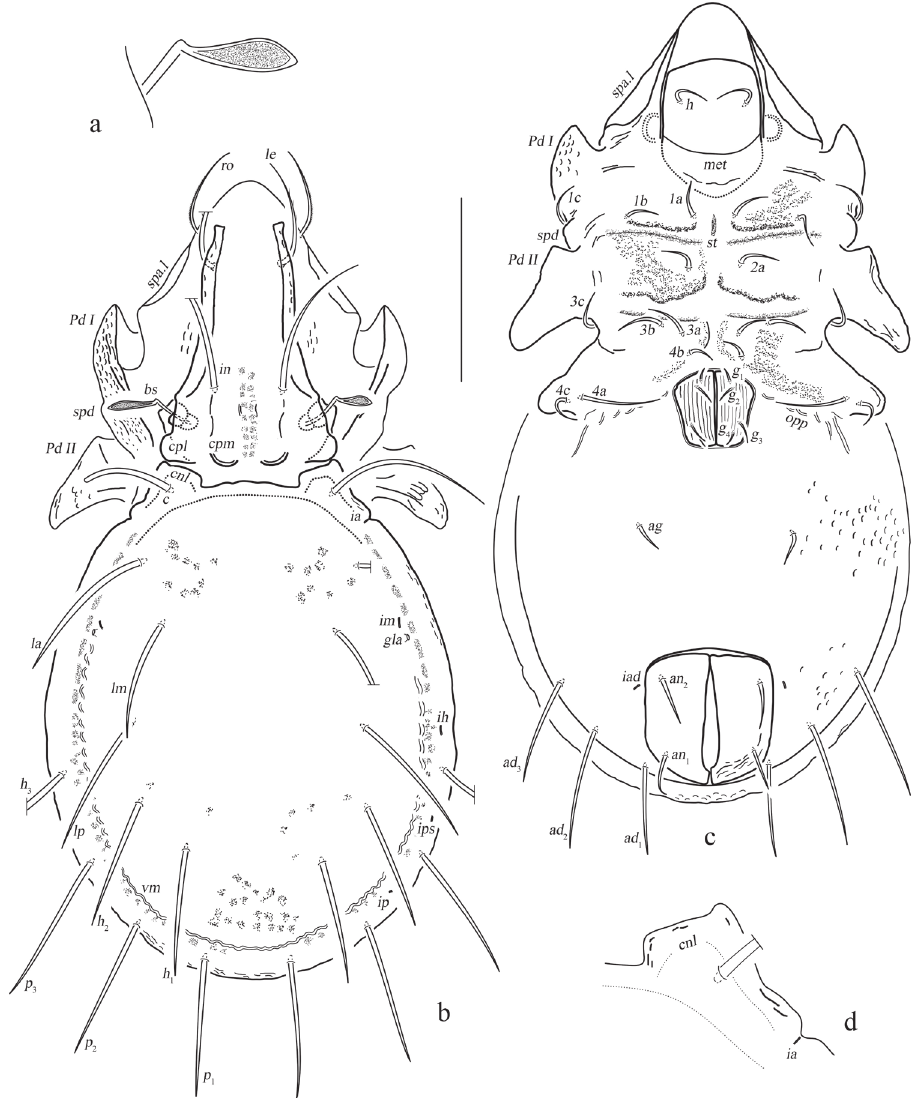
Figure 11. Eurostocepheus (Eurostocepheus) mahunkai Mondal & Kundu, 1999, adult: a bothridial seta b dorsal aspect (legs removed) c ventral aspect (legs and mouthparts removed) d lateral notogastral con- dyle (right). Abbreviations and notations explained in text. Scale bars: 200